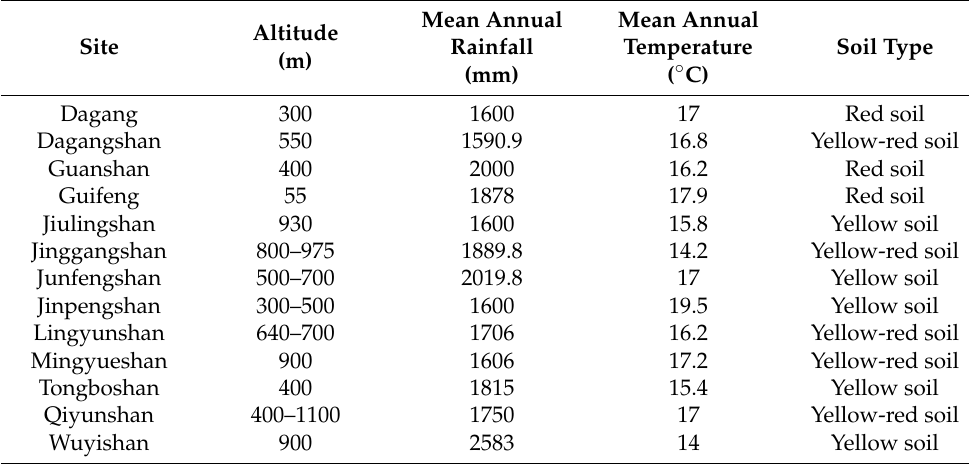
Table 1. The basic information of 13 localities for bamboo–woodland interfaces.